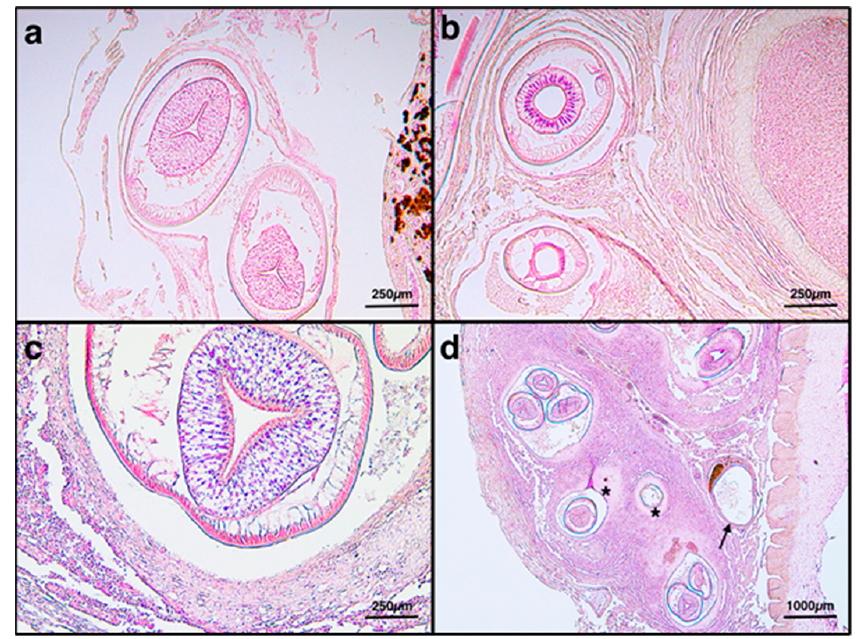
Figure 4. ( a ) Nematode-free larval stage found in the serosa, H&E 10 × . ( b ) Encysted nematode stage, H&E 10 × . ( c ) Early granuloma stage with nematodes inside a thin capsule of macrophages and epithelioid cells, H&E 10 × . ( d ) Intermediate (arrow) and mature (asterisks) granuloma stages with a thick capsule surrounded by a fibrous reaction, H&E 2.5 × .